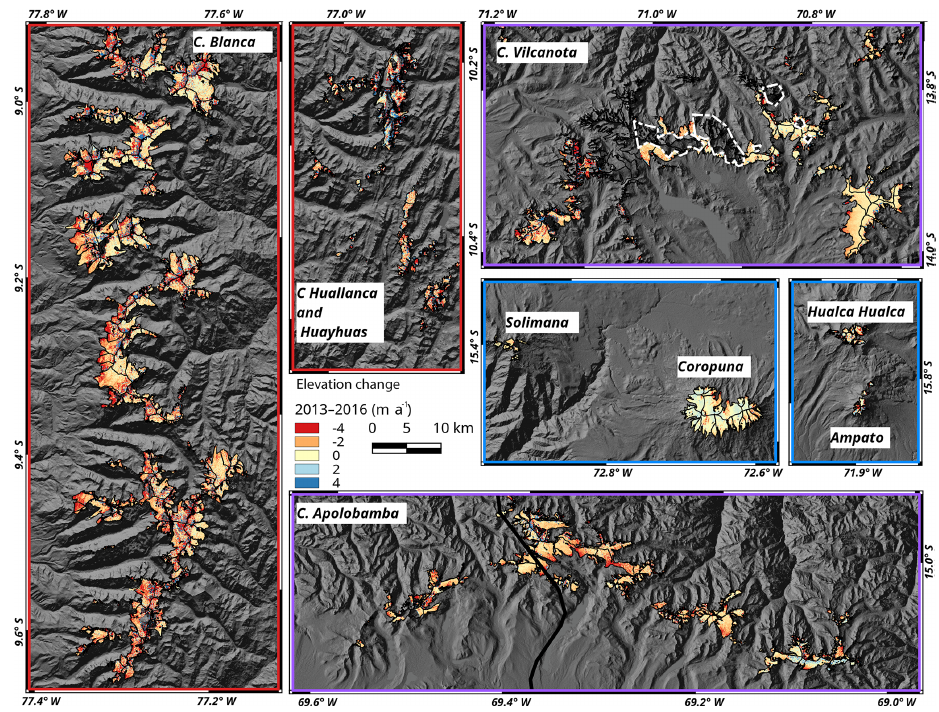
Figure 5. Surface elevation changes in the period 2013–2016 at mountain ranges in all three subregions (unfiltered). The frame colour of the panels indicates the subregions (see Fig. 1). White dashed line: masked out areas affected by phase jumps in the unwrapped interferogram. Background: SRTM DEM hillshade ©